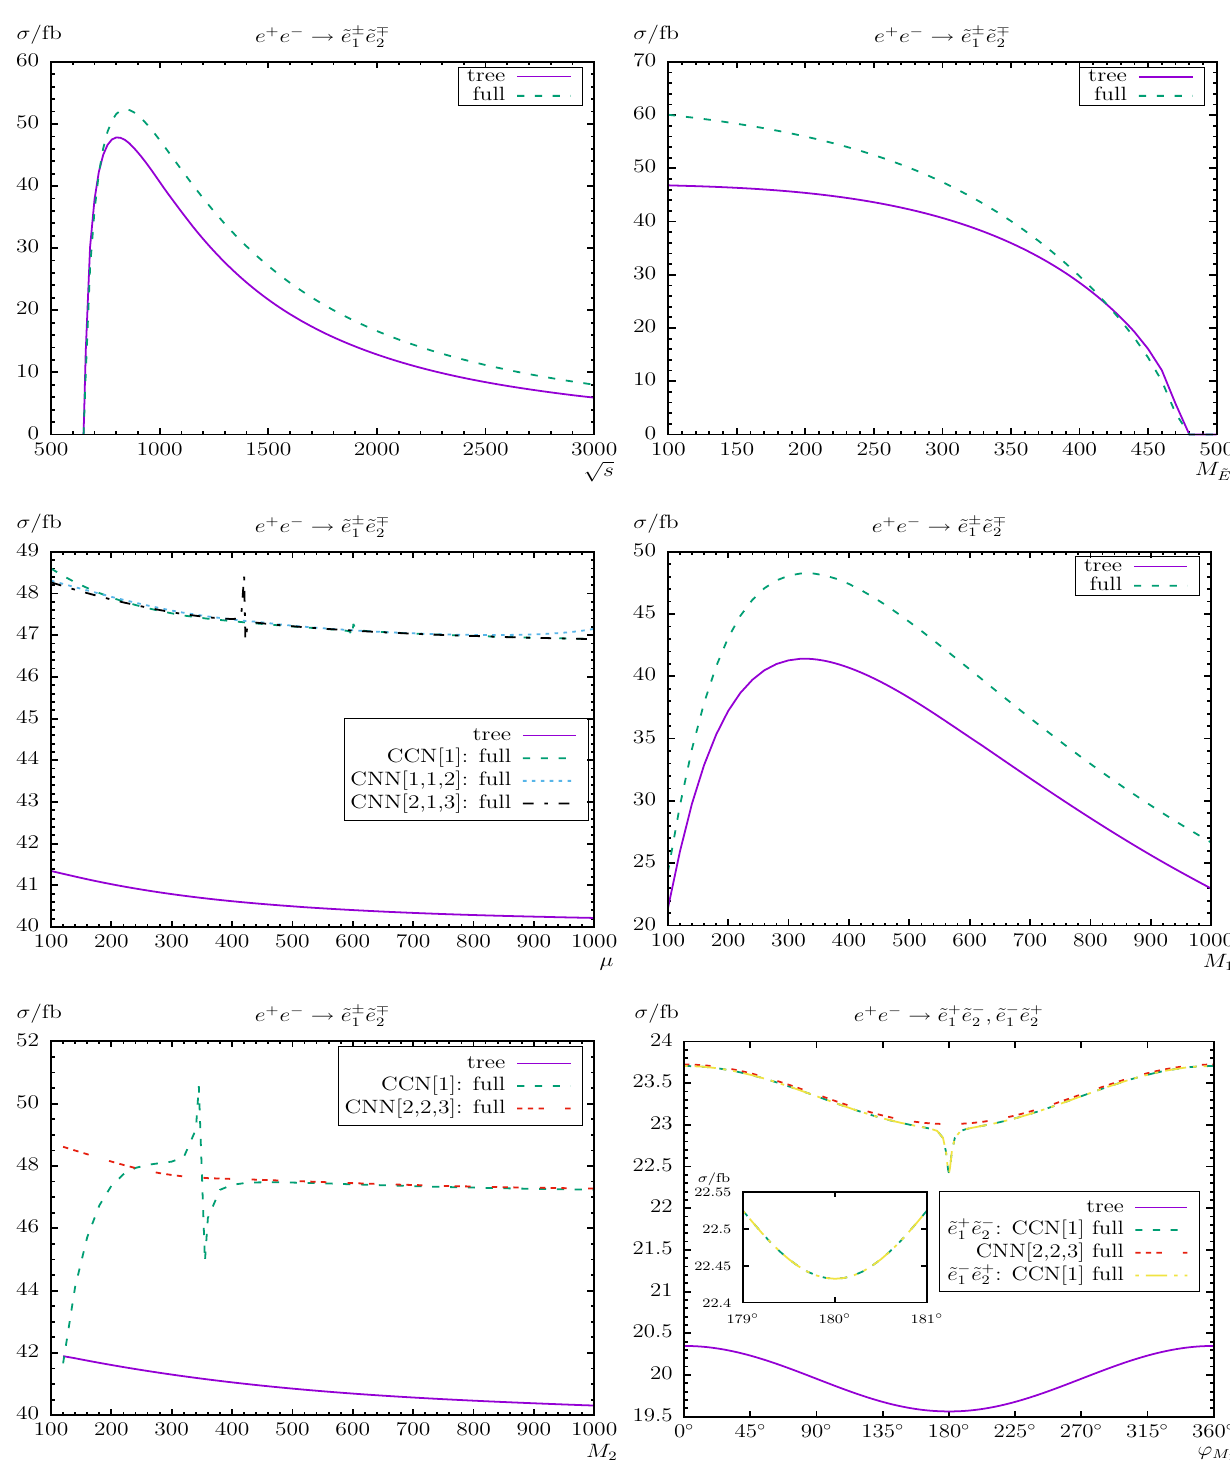
˜ e ∓ ) . Tree-level and full one-loop corrected Fig. 10 σ( e + e − → ˜ e ± (right) varied; the middle plots show μ (left) and | M 1 | (right) varied; 1 2 cross sections are shown with parameters chosen according to S ; see the lower plots show M 2 (left) and ϕ M √ s (left) and M ˜ Table 1. The upper plots show the cross sections with energies are in E